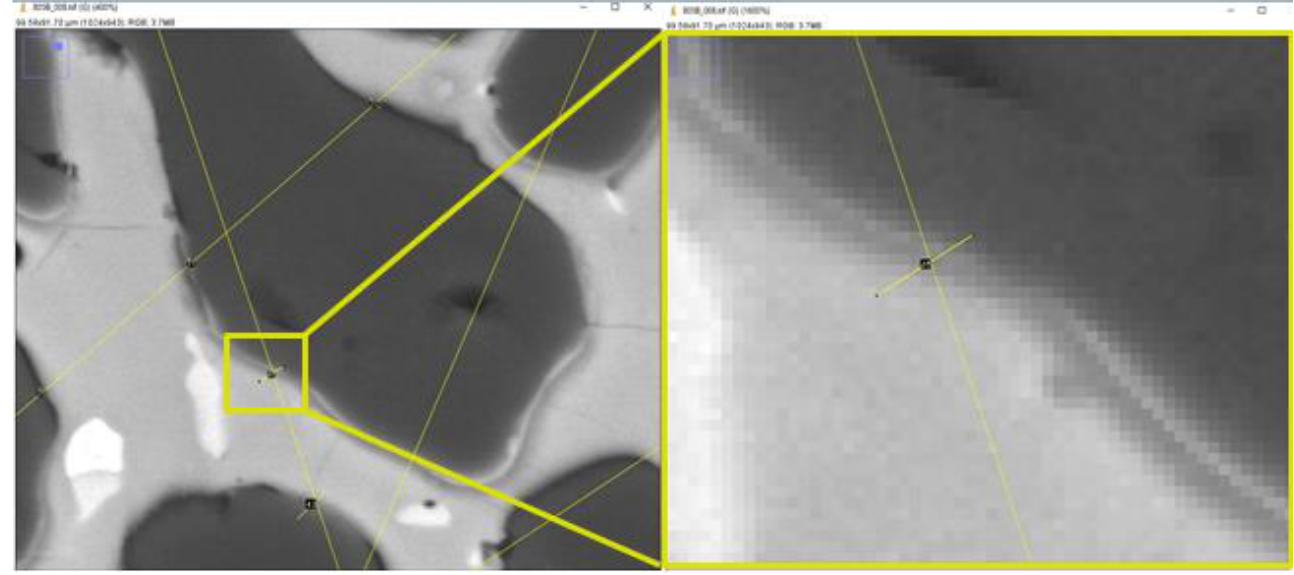
Figure 19. Magnified SEM image during linear analysis showing the source of the error resulted from blurred grain boundary.